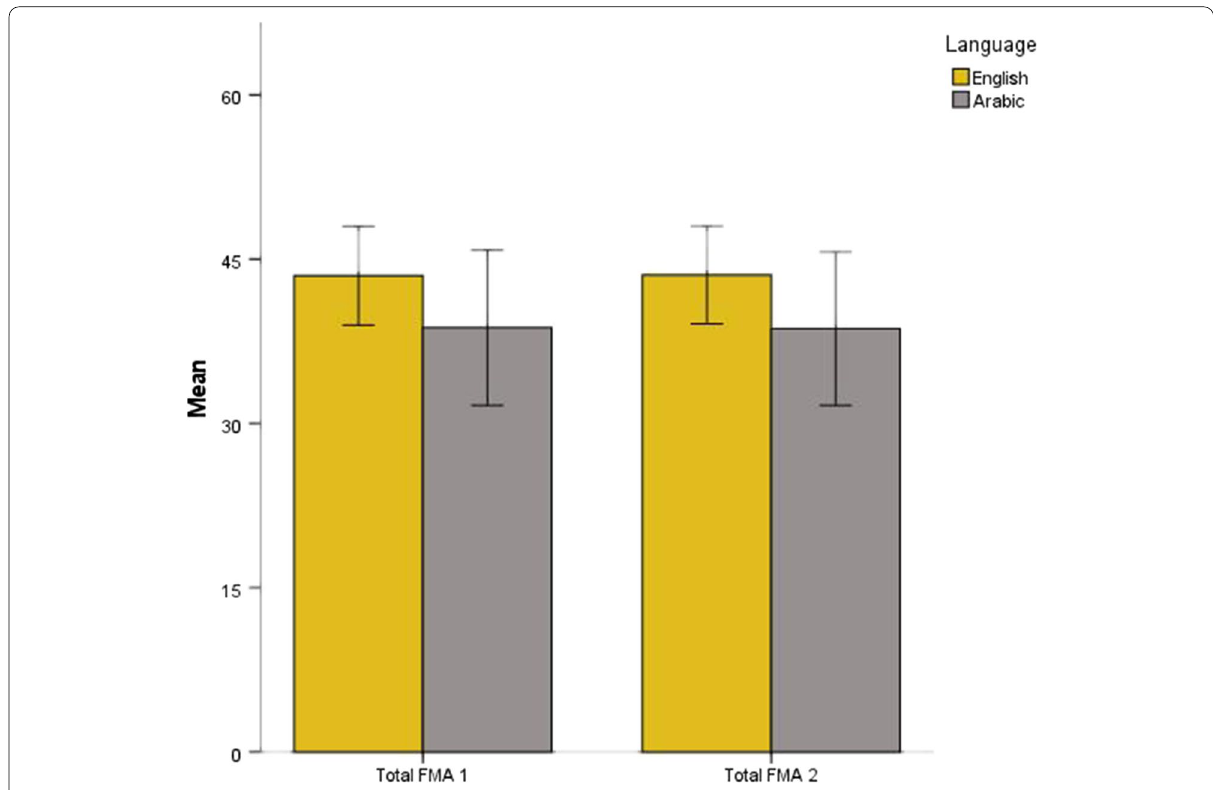
Fig. 1 FMA 1 (complete the first FMA) and FMA 2 (complete the second FMA in other